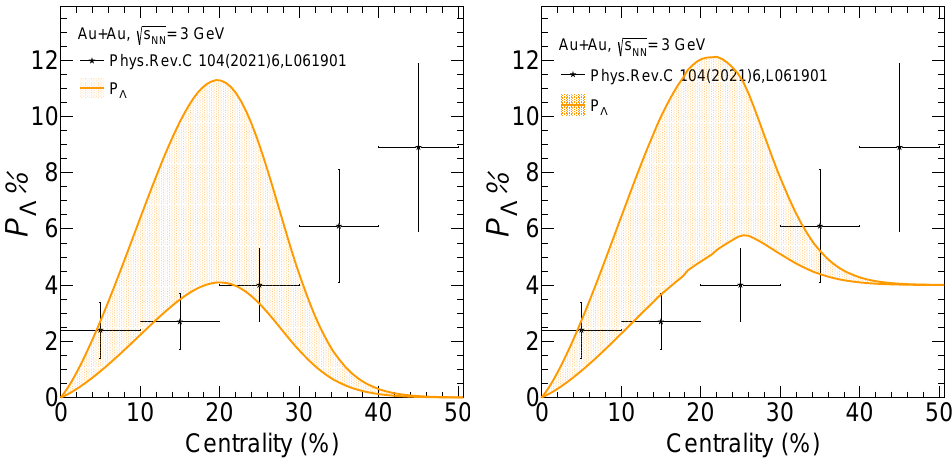
Figure 7. Λ global polarization as a function of centrality. With (right plot) and without (left plot) P Λ = 4% contribution for all centrality bins. Data for Au+Au at REC